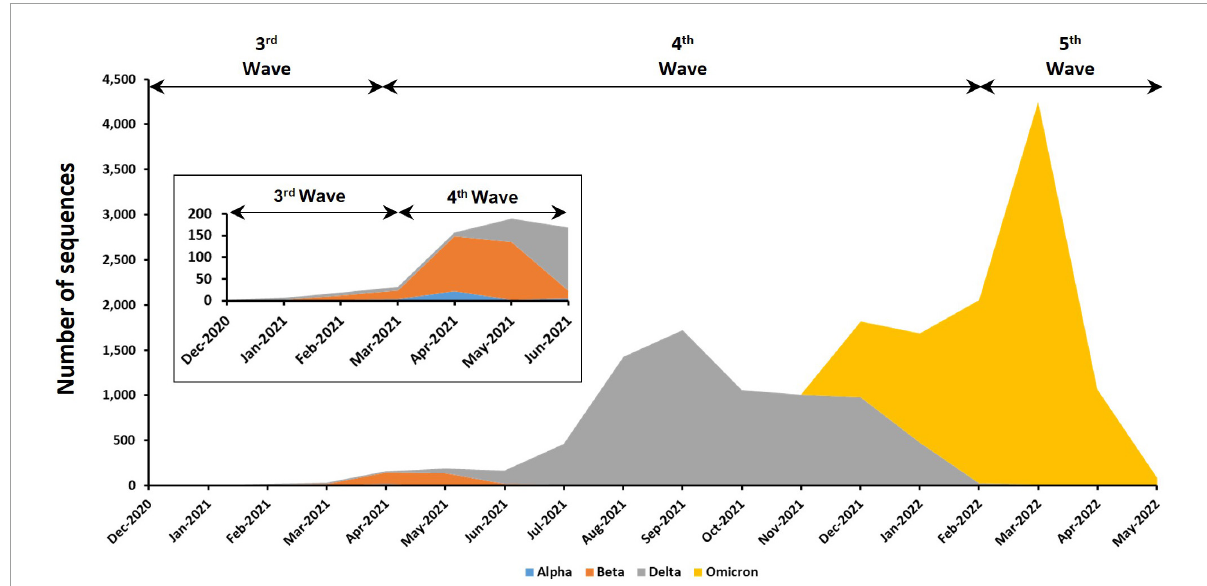
FIGURE3 Distribution of VOCs among the 17,193 genomic sequences in Malaysia. Insets are enlarged figure of the first few months of the emergence of VOC in